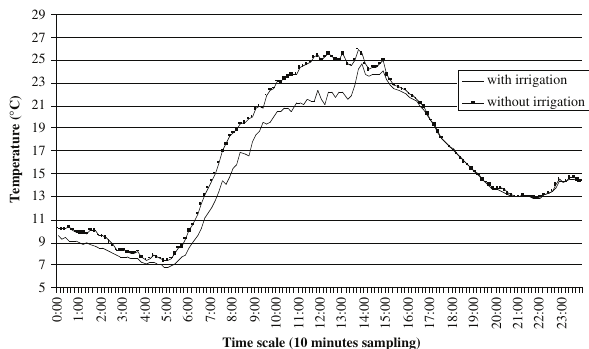
Figure 3. Irrigation. effect on the daily distribution of temperature those days when the wind speed was lower than 3m/s and temperature was higher than 20 °C - from March 15 to May 15,